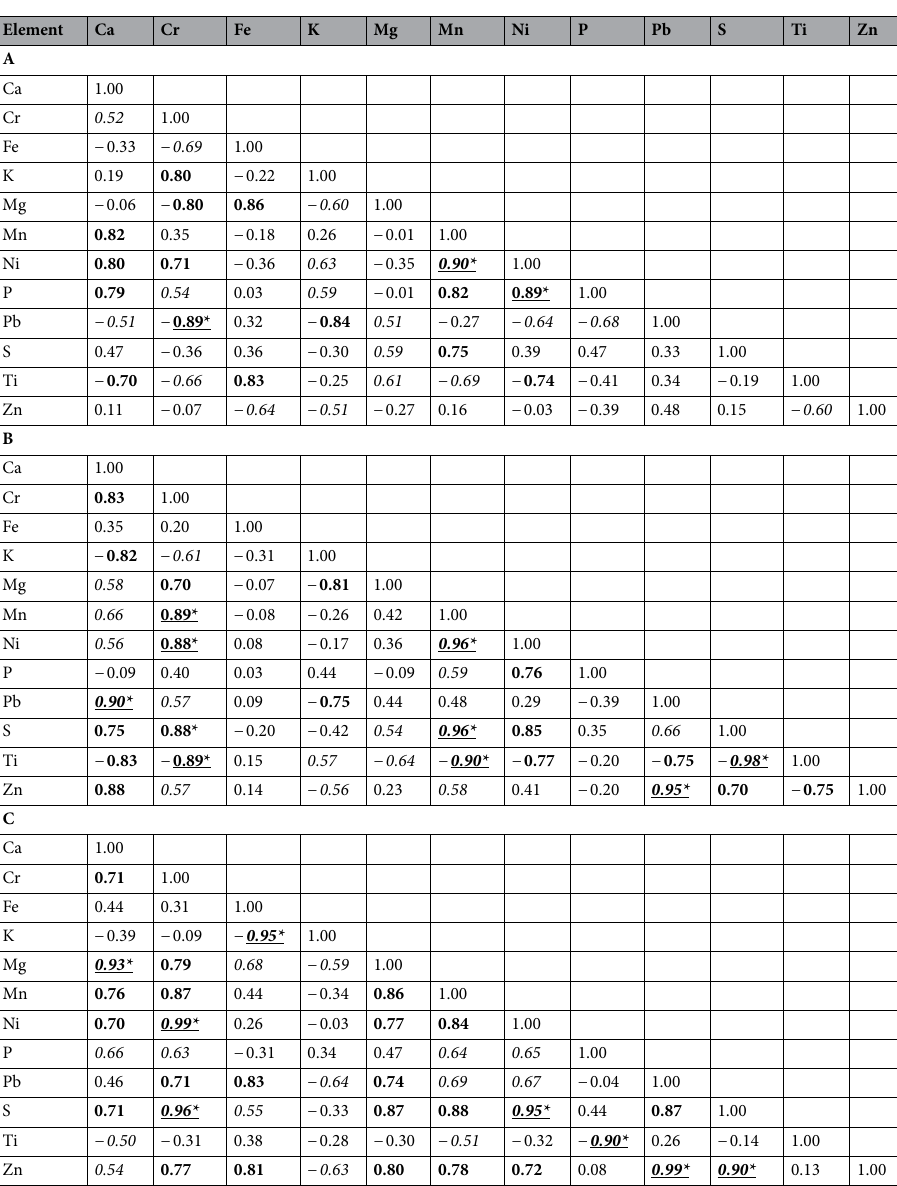
Table 3. Correlation coefficients (r x,y ) between the elements’ contents in lettuces samples growing on soil from industry areas and fertilized by (A) mix of straight fertilizers. (B) multinutrient fertilizer. (C) organic fertilizer. Designations as in the Table